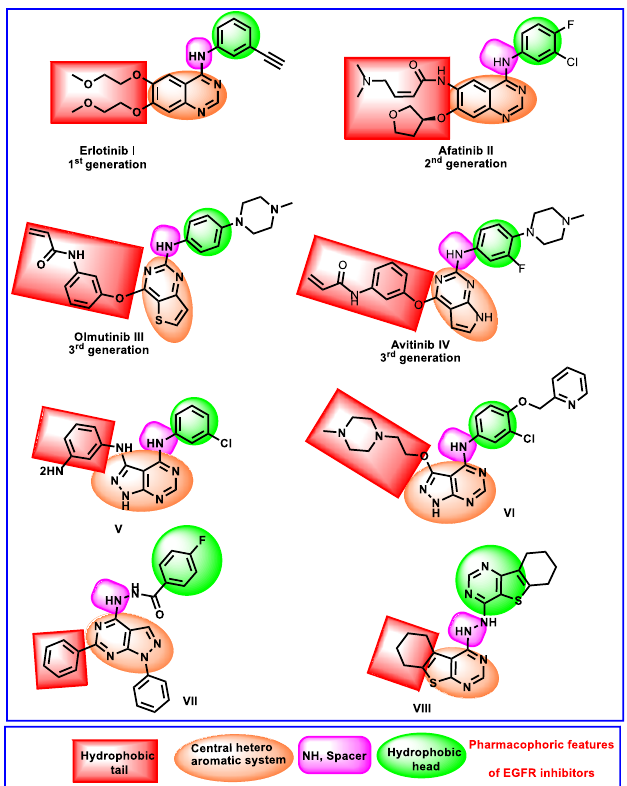
Figure 1. Some reported EGFR inhibitors to show the essential pharmacophoric features.